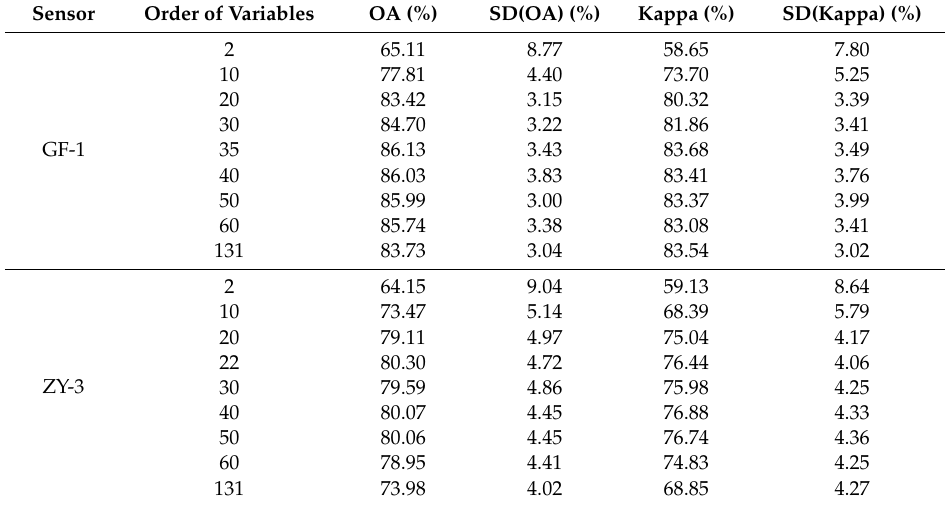
Table 7. Overall accuracy of trained RF model using the RFE-based variable selection. OA: Overall accuracy; SD: Standard deviation.